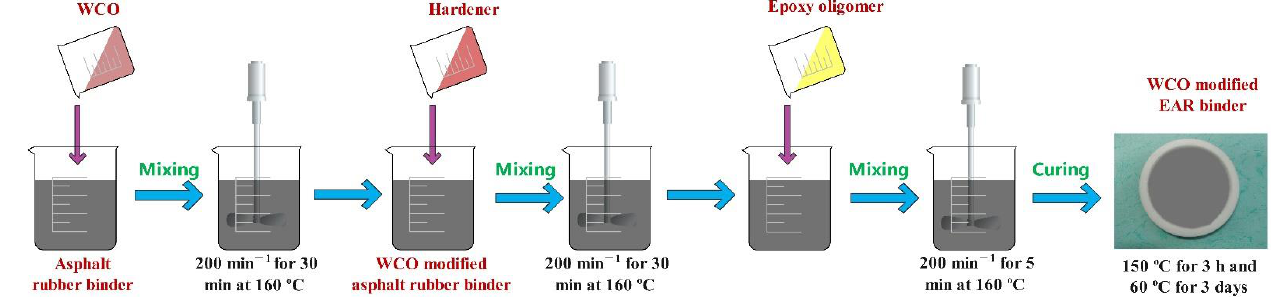
Figure 13. Preparation scheme of WCO-modified EAR binder.